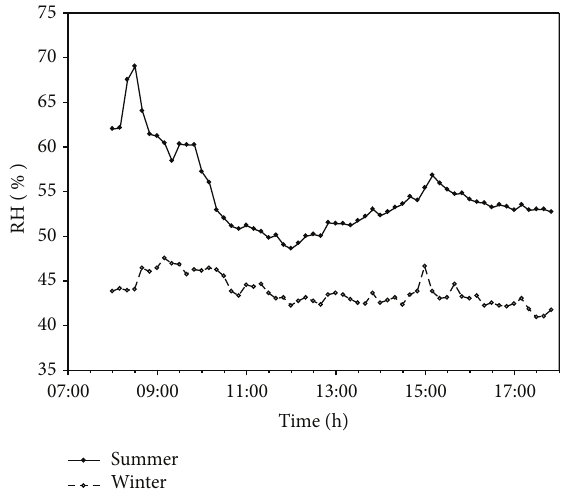
Figure 7: The hourly indoor humidity difference between summer and winter, respectively.